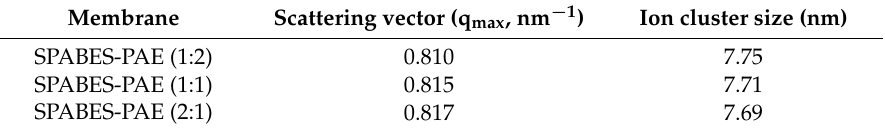
Figure S1: The DSC analysis of the membranes measured at 10 °C·min − 1 under N 2 flow; a) SPABES-PAE (1:2), b) SPABES-PAE (1:1), c) SPABES-PAE (2:1), and d) PABES-PAE (1:1); Figure S2: The (a) water uptake and (b-d) swelling ratio (length, width, and thickness) of SPABES-PAE and Nafion 212 membranes at various temperature; Table S1: The molecular weights ( M n , M w , and M z ), and PDI of copolymers; Table S2: Solubility behavior of the SPABES copolymers in various solvents.